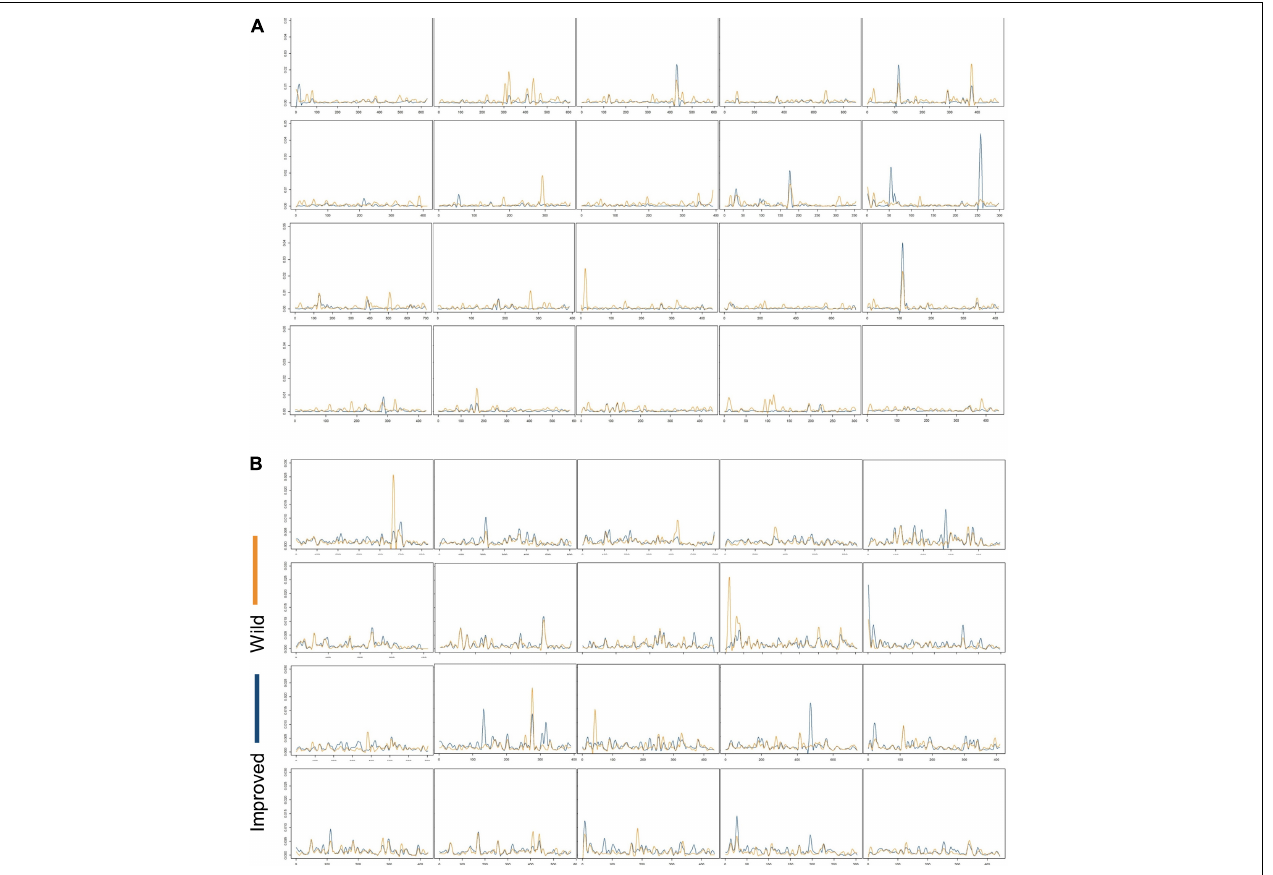
FIGURE 6 | By-locus values of within-population nucleotide diversity ( π ) for improved (blue) and wild (orange) “populations” across chromosomes 1–20 in (A) Cucurbita argyrosperma and (B) Cucurbita maxima